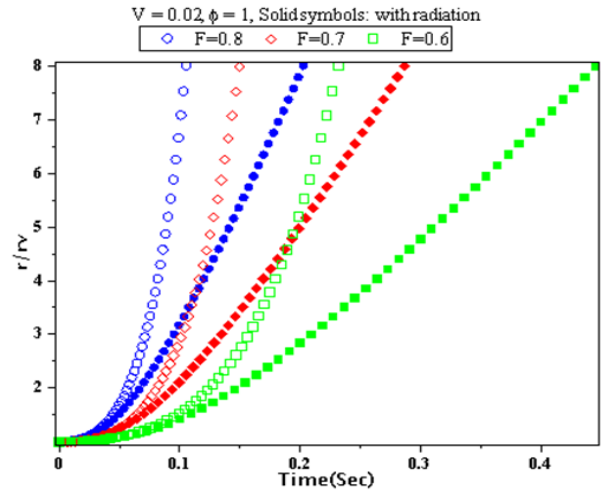
Fig. 1. Comparison between presented simulation and experiment [15].